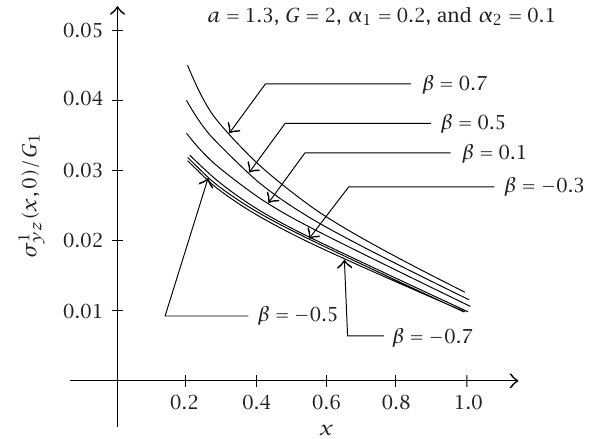
x for different values of 1 with = 0 . 2, and α = 1 2